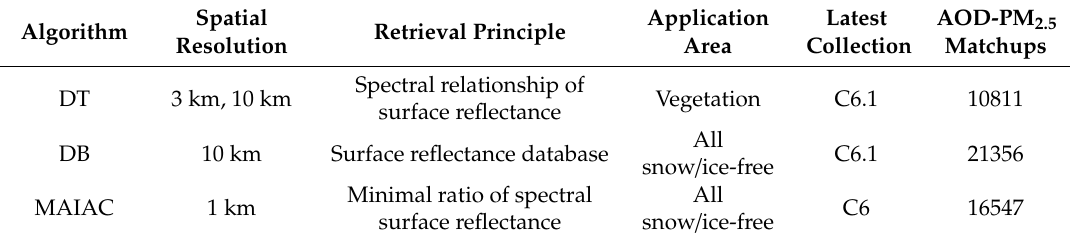
Table 1. Comparison of three primary MODIS AOD datasets. The AOD-PM 2.5 matchup denotes number of matchups for available AOD with ground measurements from the 83 sites in northern China during